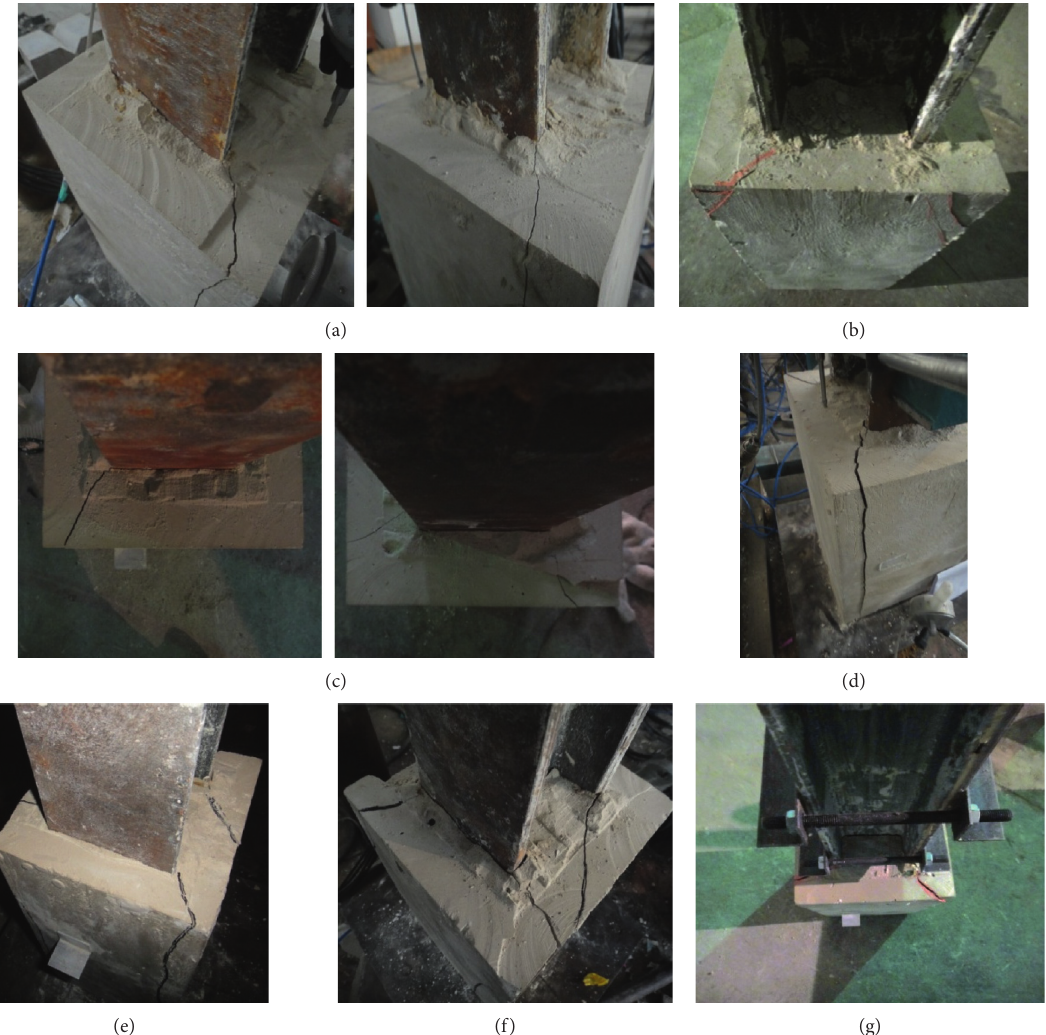
Figure 6: Crack development at the free end of the gypsum cover. (a) Specimen C-2. (b) Specimen C-5. (c) Specimen C-3. (d) Specimen C-6. (e) Specimen C-7. (f) Specimen C-8. (g) Specimen C-9.